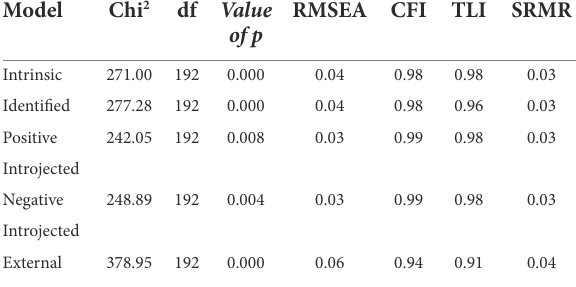
TABLE 3 Fit Indices of the